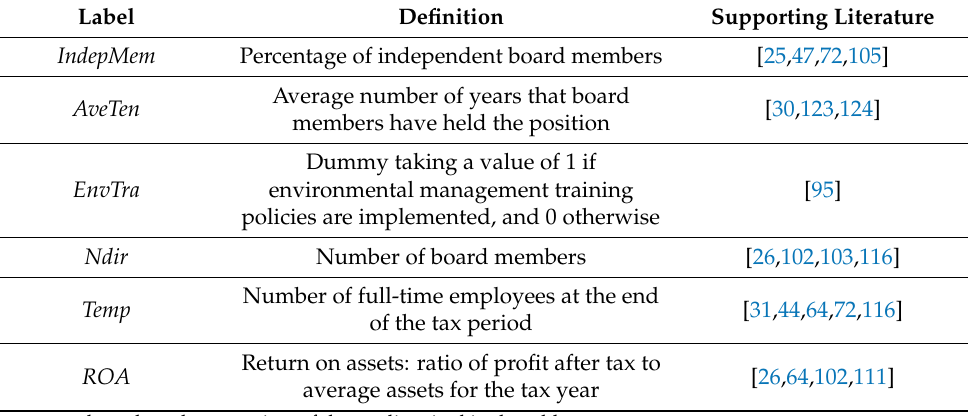
Table 5. Control